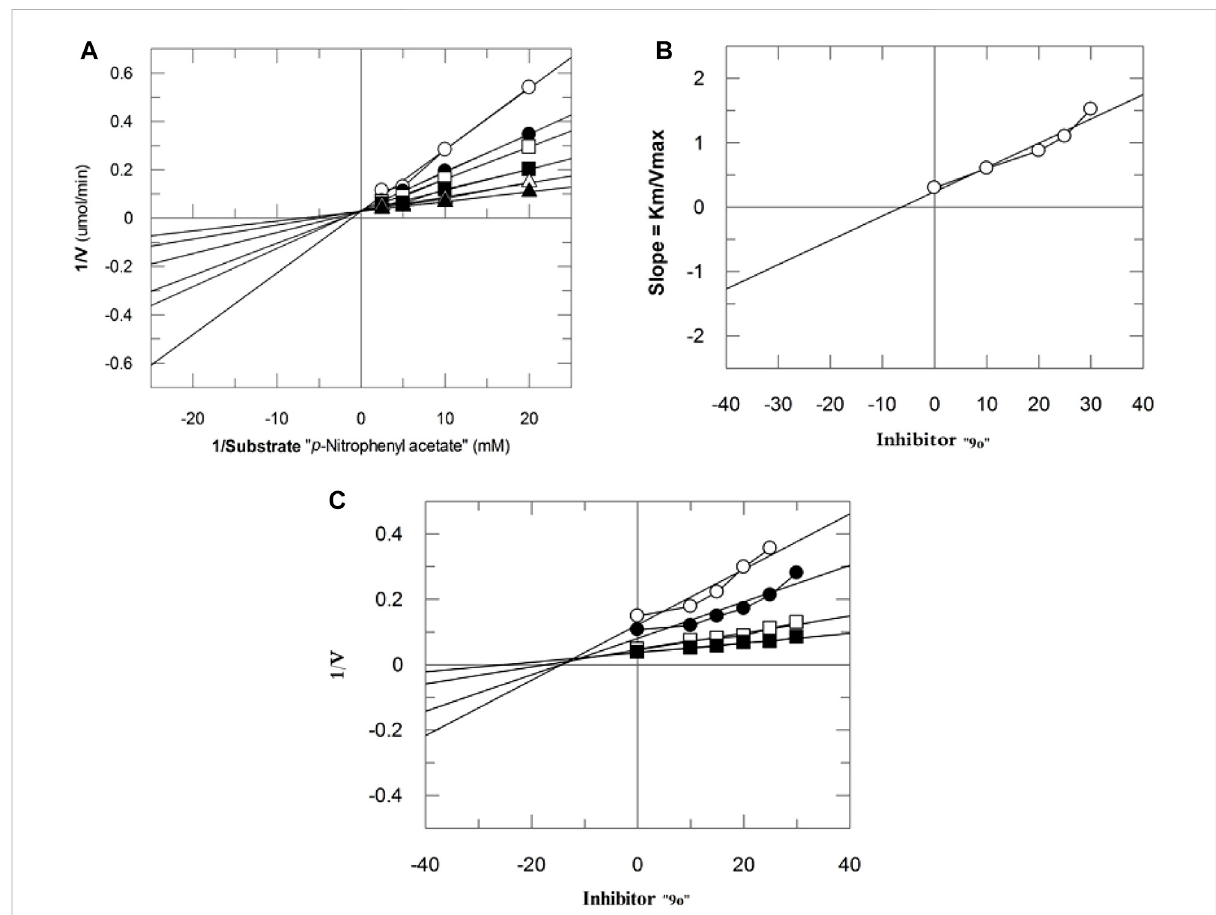
FIGURE 3 Inhibition of bCA-II by 9o . (A) Lineweaver – Burk plot of the reciprocal of the rate of reaction (velocities) vs . reciprocal of the substrate (p-nitrophenyl acetate) in the absence ( ▲ ), 7 µ M ( Δ ), 10 µ M ( ■ ), 13 µ M ( □ ), 16 µ M ( C ), and 19 µ M ( ○ ) of 9o . (B) Secondary replot of Lineweaver – Burk plot between the slopes of each line on the Lineweaver – Burk plot vs . different concentrations of 9o . (C) Dixon plot of the reciprocal of the rate of reaction ( velocities ) vs . different concentrations of 9o .